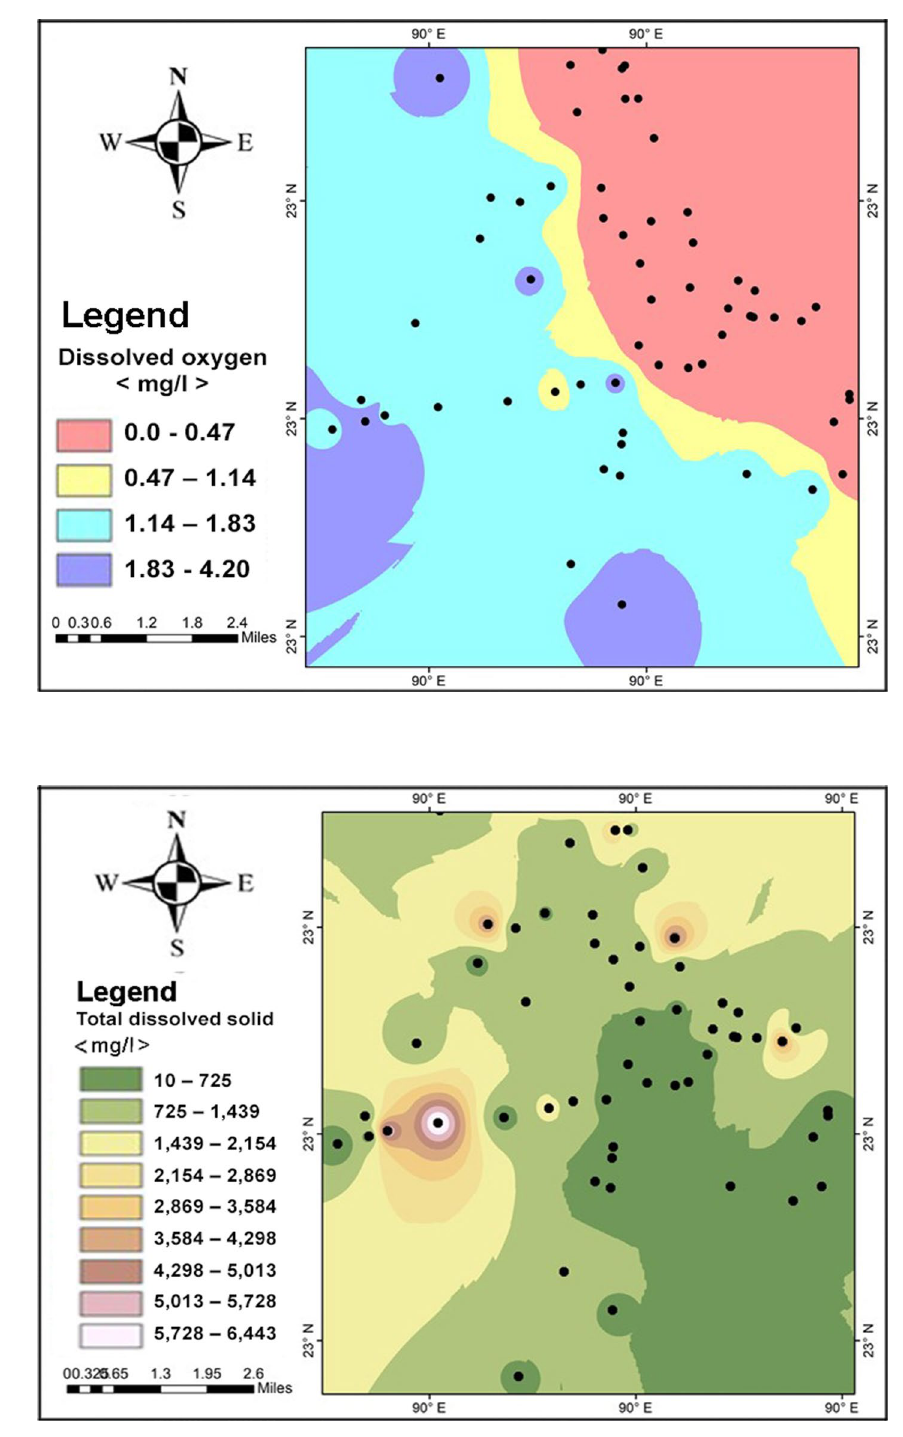
Fig. 5 Spatial distribution of DO in selected tube wells water